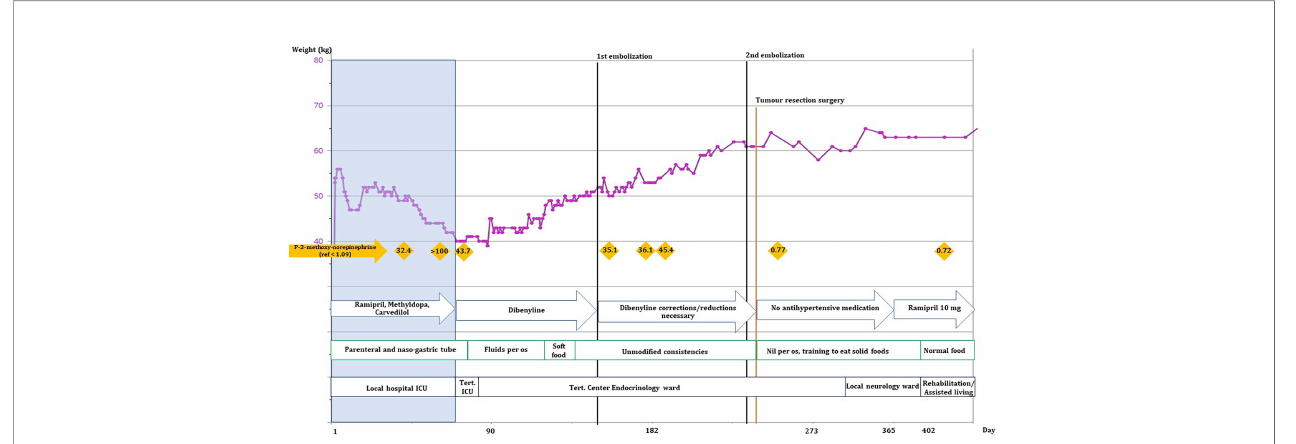
FIGURE 1 | Development of the patient ’ s weight (kg), normetanephrine levels, antihypertensive medicine, nutritional intake, and physical location over the fi rst 365 days of hospitalization. Black lines: embolization procedures, orange line: tumor resection surgery, orange rhombes: plasma-3-methoxy-norepinephrine levels (nmol/ L), blue arrows: changes in blood pressure medications, green blocks: changes in the patient ’ s ability to drink/eat. She was at no point able to sustain nutrient intake without supplemental nutrition by naso-gastric tube. Black boxes show the patient ’ s